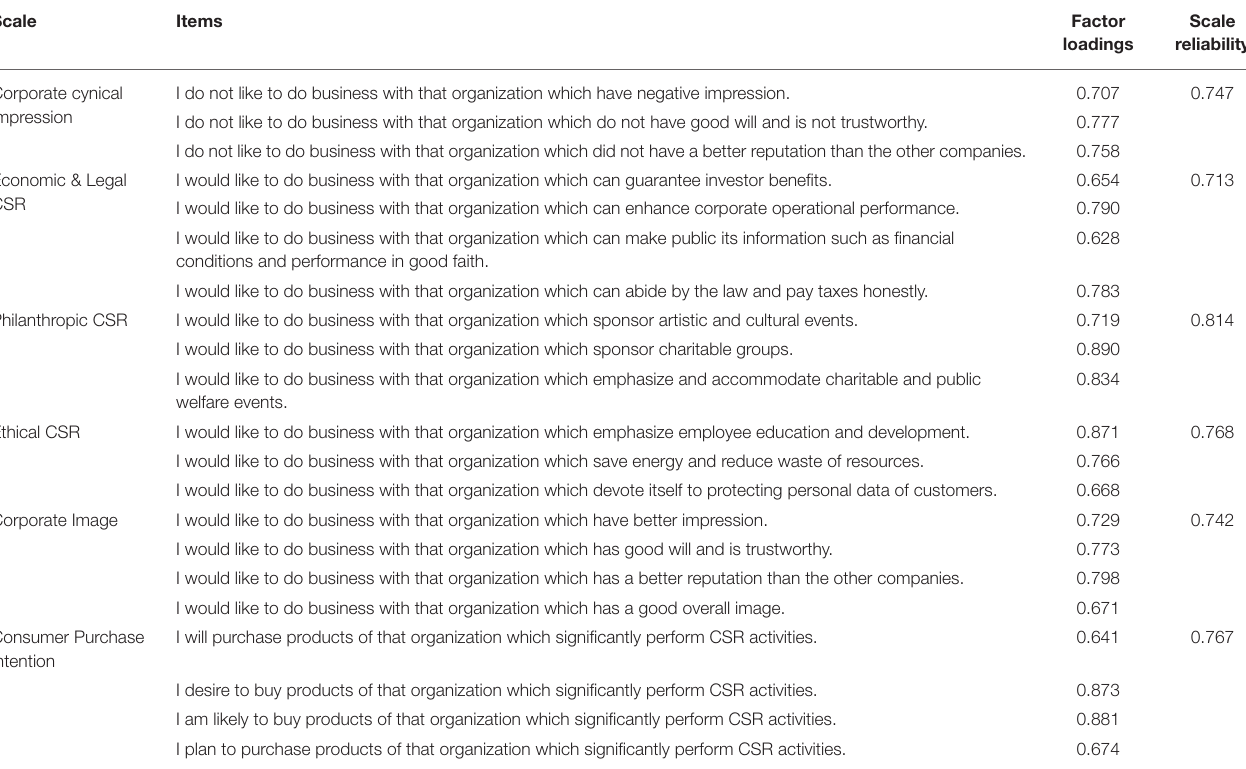
TABLE 4 | Factor loading of items.